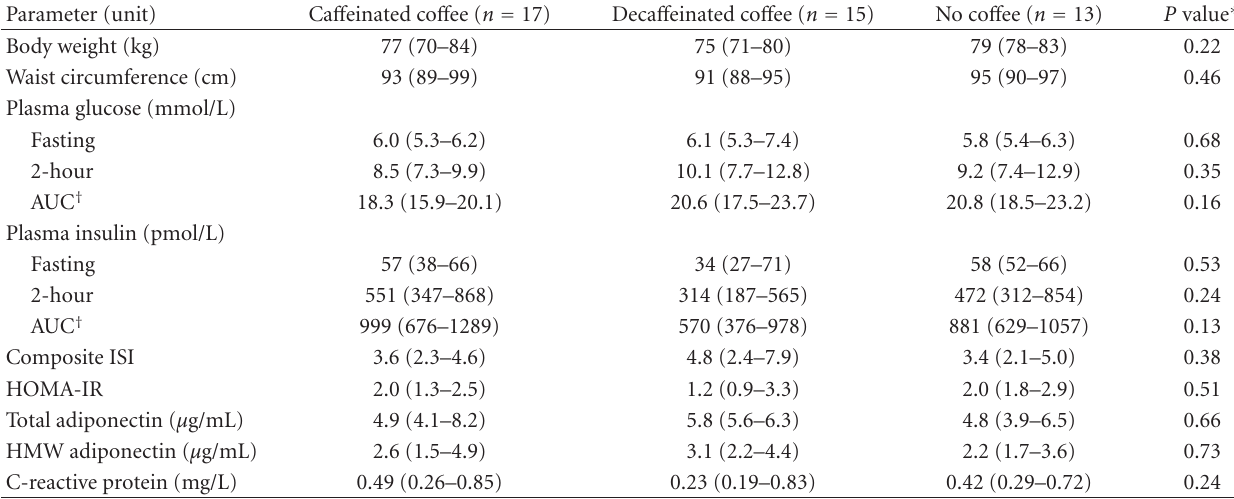
Figure 1: Trial profile. Table 1: Anthropometric measures, glucose metabolism parameters, and serum adiponectin and C-reactive protein at